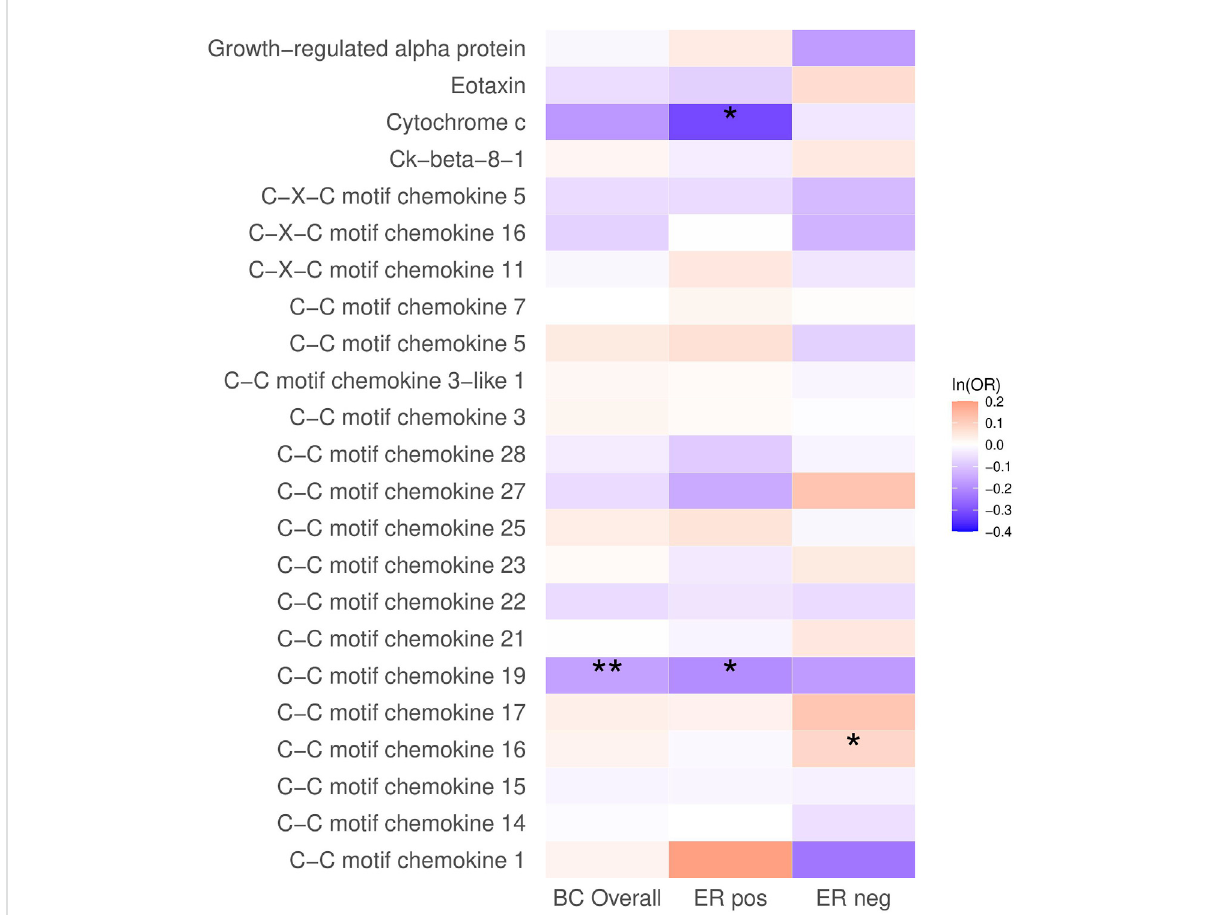
FIGURE 2 The causal association between plasma chemokines and breast cancer survival. HR: hazard ratio. Statistical signi fi cance is indicated by ** ( p < 0.01) and * ( p < 0.05). The estimates are based on the fi xed effect of the inverse varianceweighted method or Wald ratio method for meta-analyzing individual SNP results. HRs show the risk of breast cancer overall and by subtypes per SD increase of ranked-inverse normalized concentration in exposure to plasma chemokines.